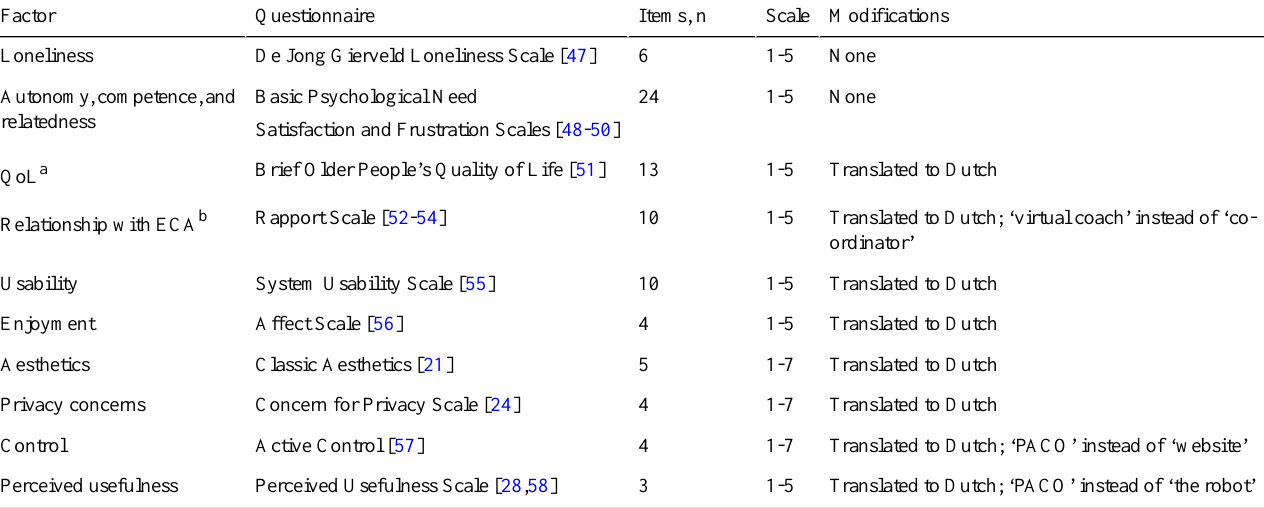
Table 3. Details of the questionnaires.